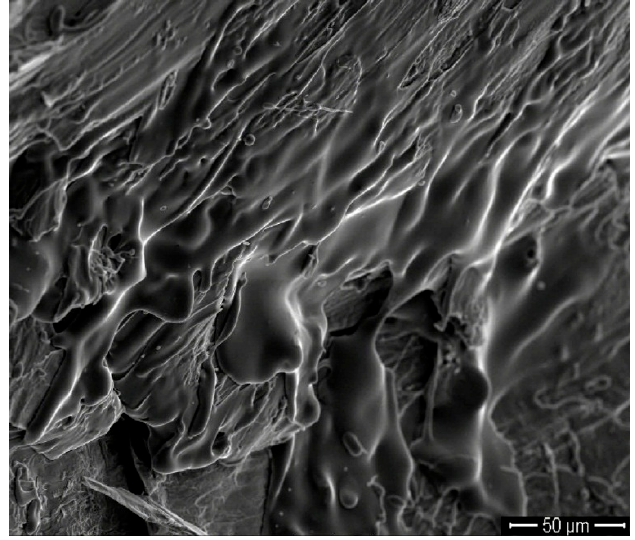
Figure 15. Local SEM image on the fracture surface of Zr 55 Al 8.9 Ni 7.3 Cu 28.8 BMG.